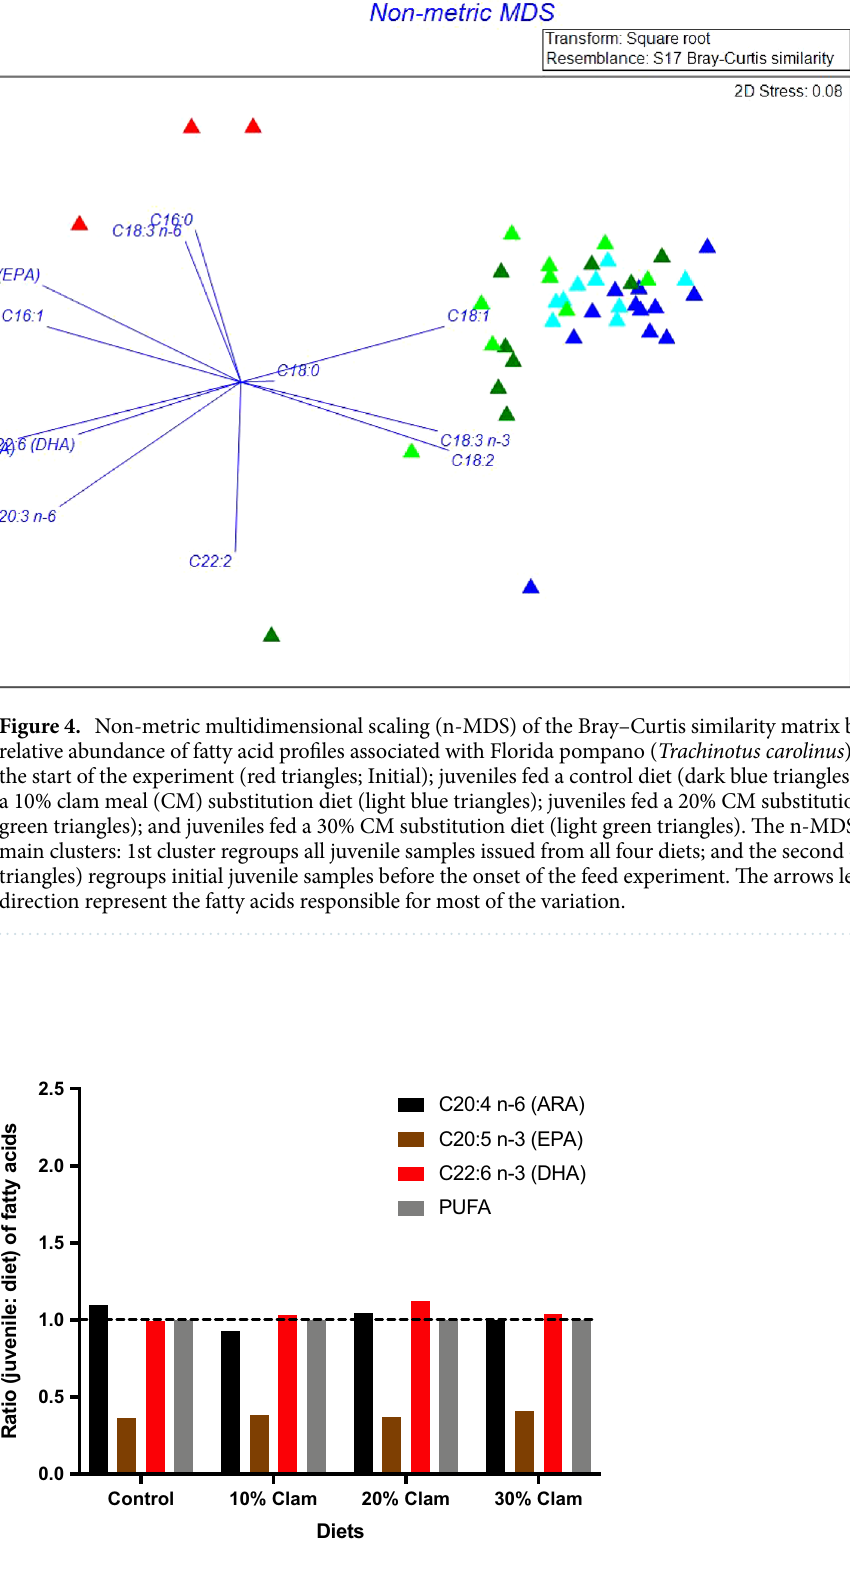
Figure 5. Ratio (juvenile: diet) of fatty acids in Florida pompano ( Trachinotus carolinus ) juveniles after a 12-week feeding trial with a control diet, and a 10%, 20%, and 30% clam meal (CM) substitution into the fish meal control diet. The dashed line (ratio = 1) indicates equal amounts of fatty acids in juveniles and in the diet. ARA, arachidonic acid; EPA, eicosapentaenoic acid; DHA, docosahexaenoic acid; PUFA, polyunsaturated fatty